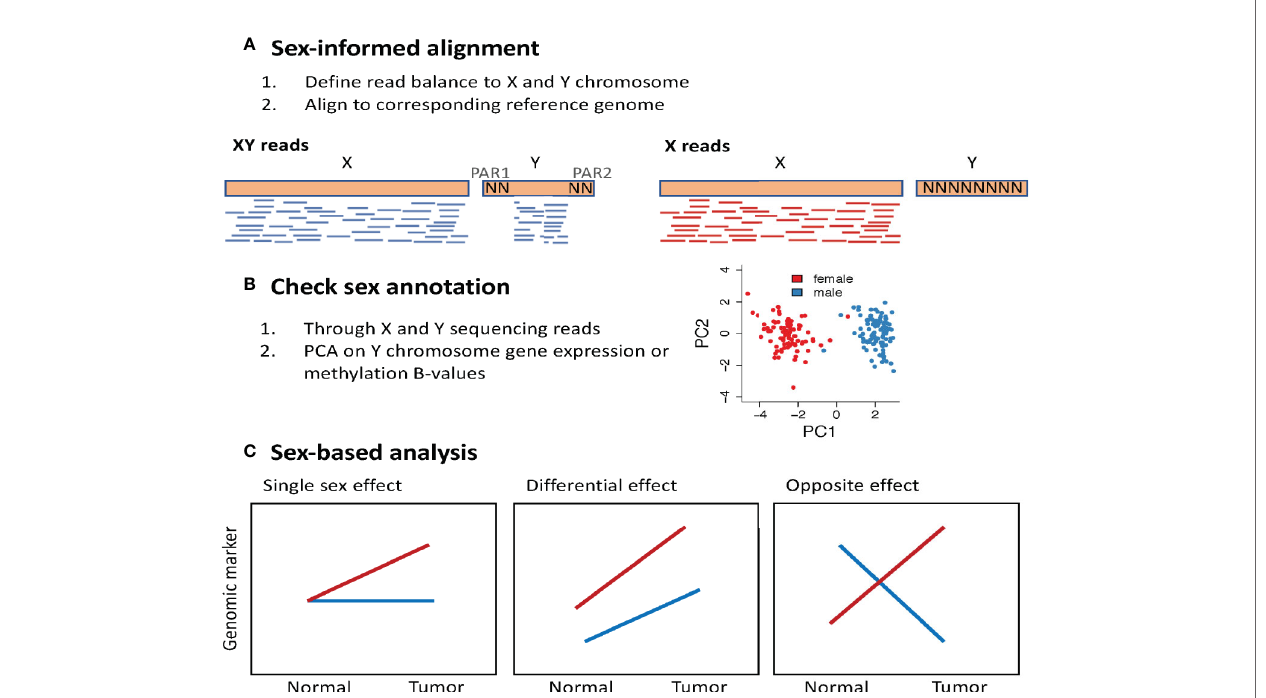
FIGURE 5 | Methodological approach to study sex differences in genomics. (A) Perform sex-informed sequence alignment. The framework proposed in the XYalign tool (153), fi rst identi fi es whether the sequencing reads are derived from an XX or XY genome, considering the balance of reads aligned to X and Y chromosomes. Next, sequencing reads from an XX genome are aligned against a reference genome with the Y chromosome masked, and sequencing reads from an XY genome are aligned against a reference genome masked for regions in the Y that are identical to X, the pseudoautosomal regions (PAR). (B) Use the genomic data to annotate biological sex based on sex chromosome complement. (C) Sex-based analysis may show how the effect of a genomic marker varies between males and females. PCA, Principal component